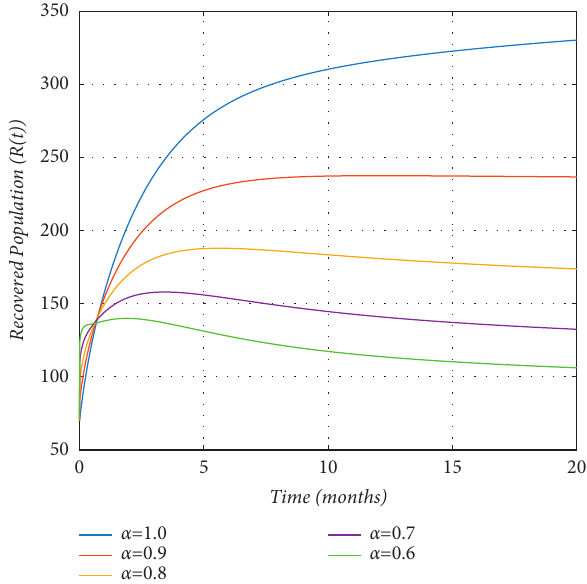
Figure 4: The graph demonstrates the dynamics of the recovered population against different values of the fractional-order pa- rameter ( α ), and the initial sizes of the population are ( 100 , 90 , 80 , 70 , 60 ) .